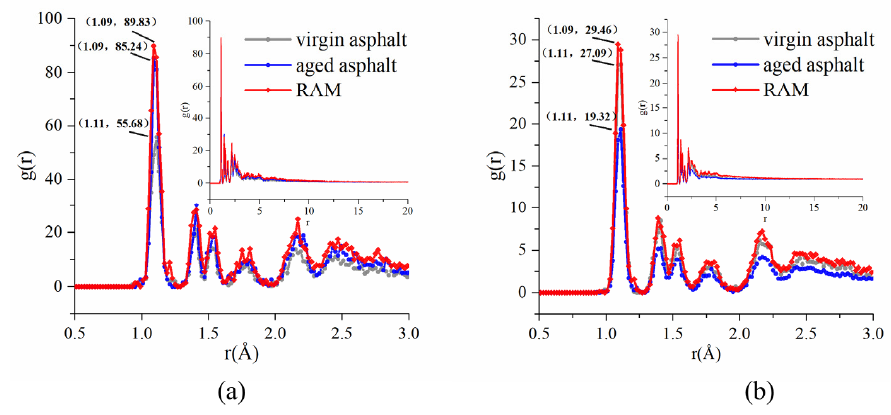
Figure 10. RDFs of SARA components: ( a ) asphaltene–asphaltene; ( b ) asphaltene–resin.